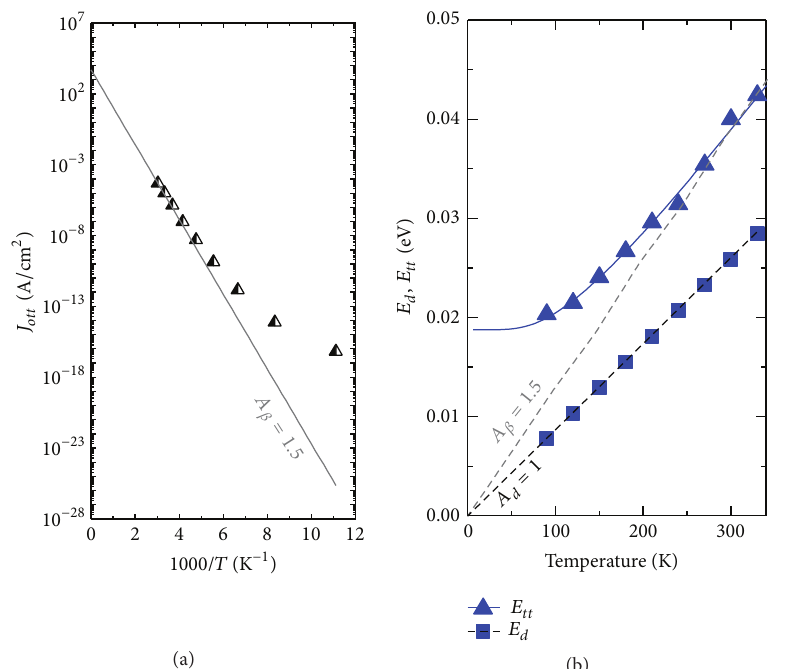
Figure 8: Dependencies of the Ge “subcell” diode parameters of thermotunneling ( 𝐸 𝑡𝑡 , 𝐽 𝑜𝑡𝑡 ) current component and thermal potential ( 𝐸 𝑑 ) of the diffusion current on the value of inverse (a) and forward (b) absolute temperature.